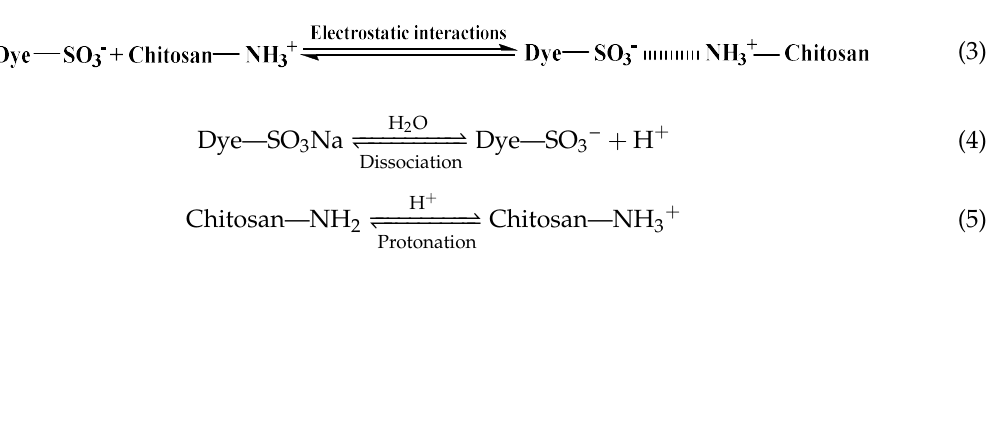
Figure 2. Adsorption capacities of the β-chitosan (CS) and β-chitosan/triethylenetetramine- functionalized graphene oxide (CSGO) adsorbents for C.I. Reactive Blue 221 Dye (RB221) with respect to the pH.